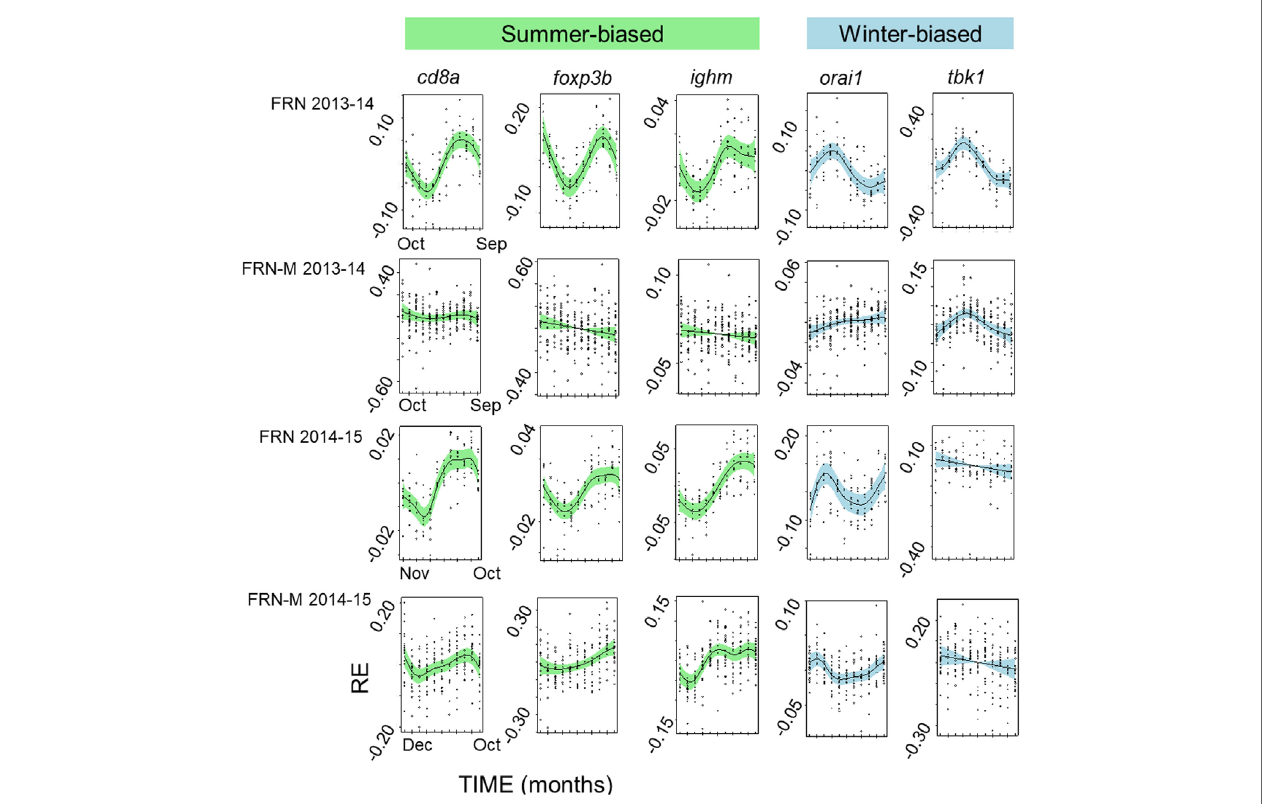
FigUre 6 | Seasonally variable expression in individual immunity-associated genes in fish from an upland lake (FRN) and from semi-natural outdoors mesocosm habitats stocked from the lake (FRN-M). Relative gene expression (RE) is shown for two annual cycles (2013–2014 and 2014–2015) based on analysis in generalized additive mixed models and plotted (centered) on the scale of the model linear predictor; lines represent non-parametric smoothers for time with 95% confidence intervals shaded and plotted points are partial residuals. Genes shown are typically relatively highly expressed in winter (winter-biased) or in summer (summer- biased) in wild habitats (22). Seasonal expression patterns are greatly diminished in the mesocosms, with inconsistent effects on different